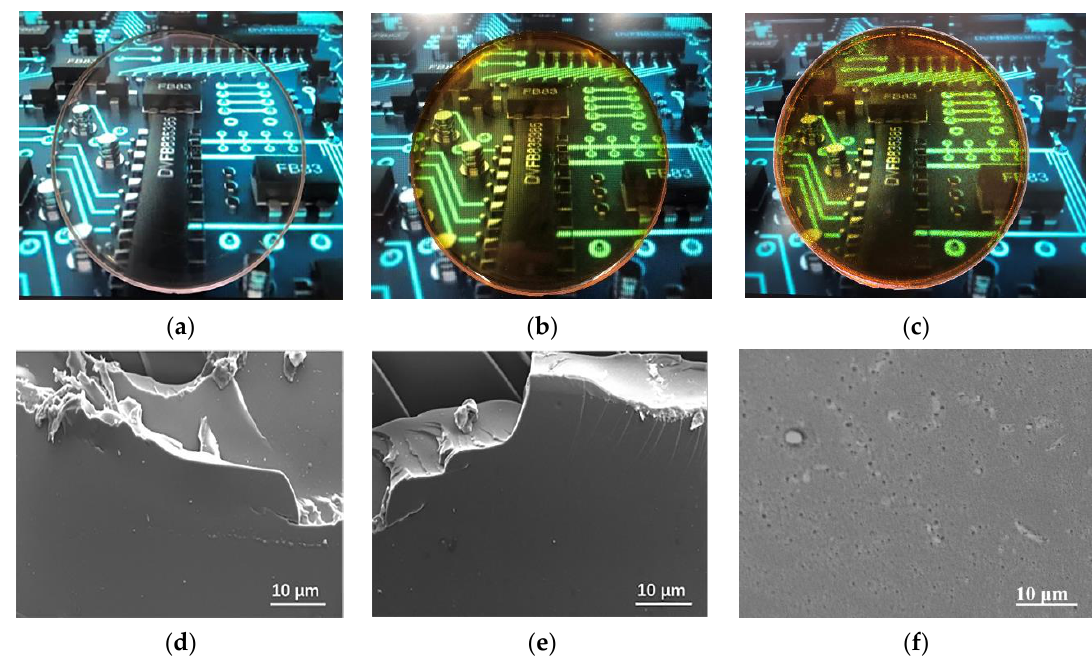
Figure 2. Photographs of ( a )ER sheet, ( b ) 9-DG-ER sheet and ( c ) 9-G/ER sheet; SEM images of the cross section of ( d ) ER sheet, ( e ) 9-DG-ER sheet and ( f ) 9-G/ER sheet.